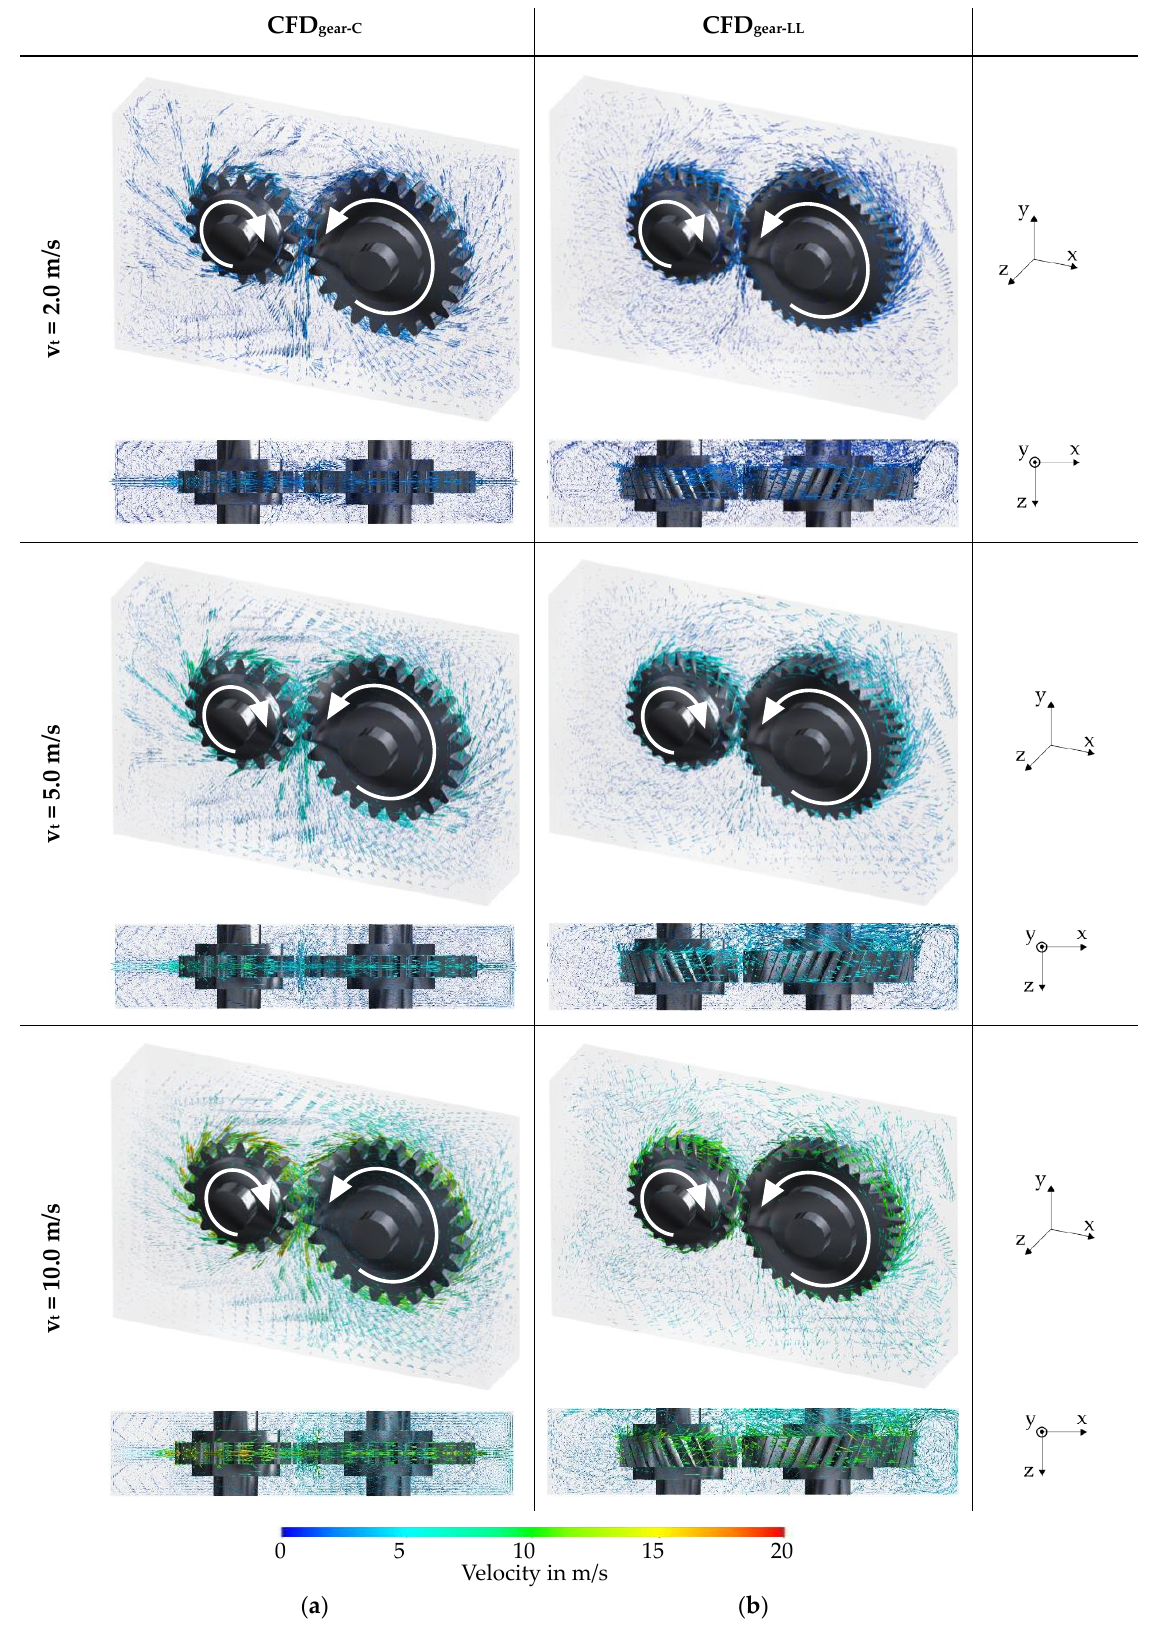
Figure 5. Isothermal flow fields in 3D view and top view for v t = {2.0; 5.0; 10.0} m/s based on a steady-state calculation for gear-C ( a ) and gear-LL ( b ).